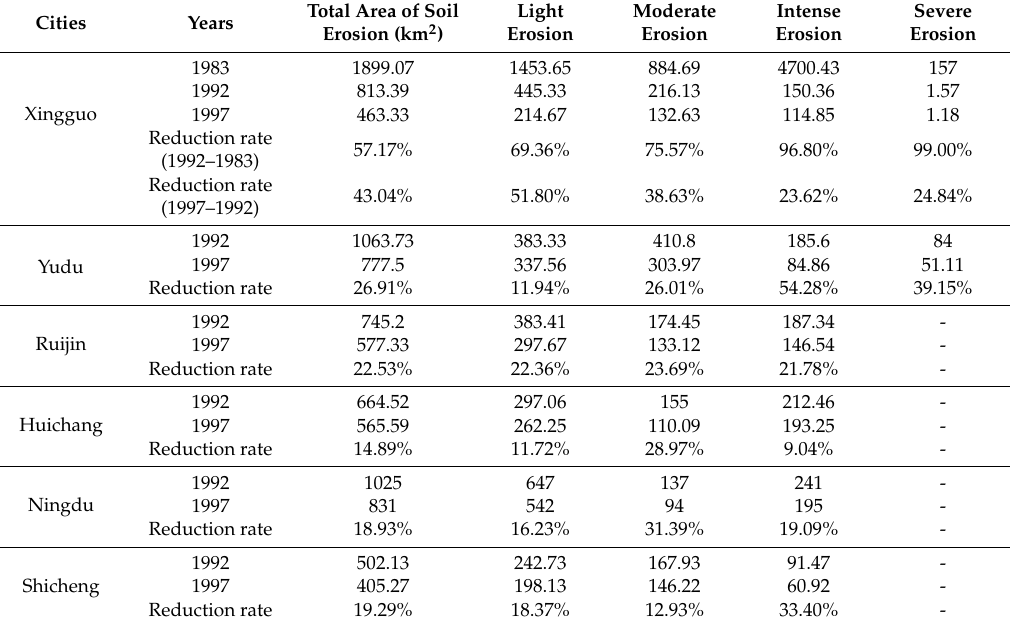
Table 6. The governance of water and soil erosion in the six counties of the Gongshui River Basin.